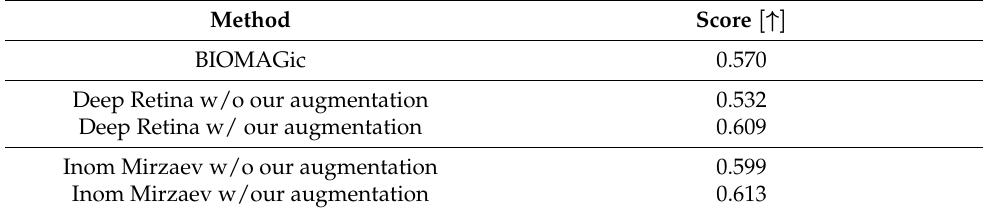
Table 1. Evaluation scores of different segmentation methods.